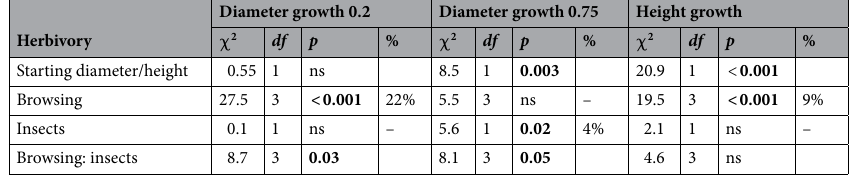
Table 2. ANOVA (type II) test results for linear mixed model testing the growth response (height and diameter (at both 0.2 m and 0.75 m stem height)) in relation to starting height/diameter and the herbivory treatments (browsing and insects) and their interaction, year 2 (2017) of the experiment. Significant p-values are marked in bold. The ‘%’ column shows the percentage difference in growth increment on trees exposed to browsing or insects compared to